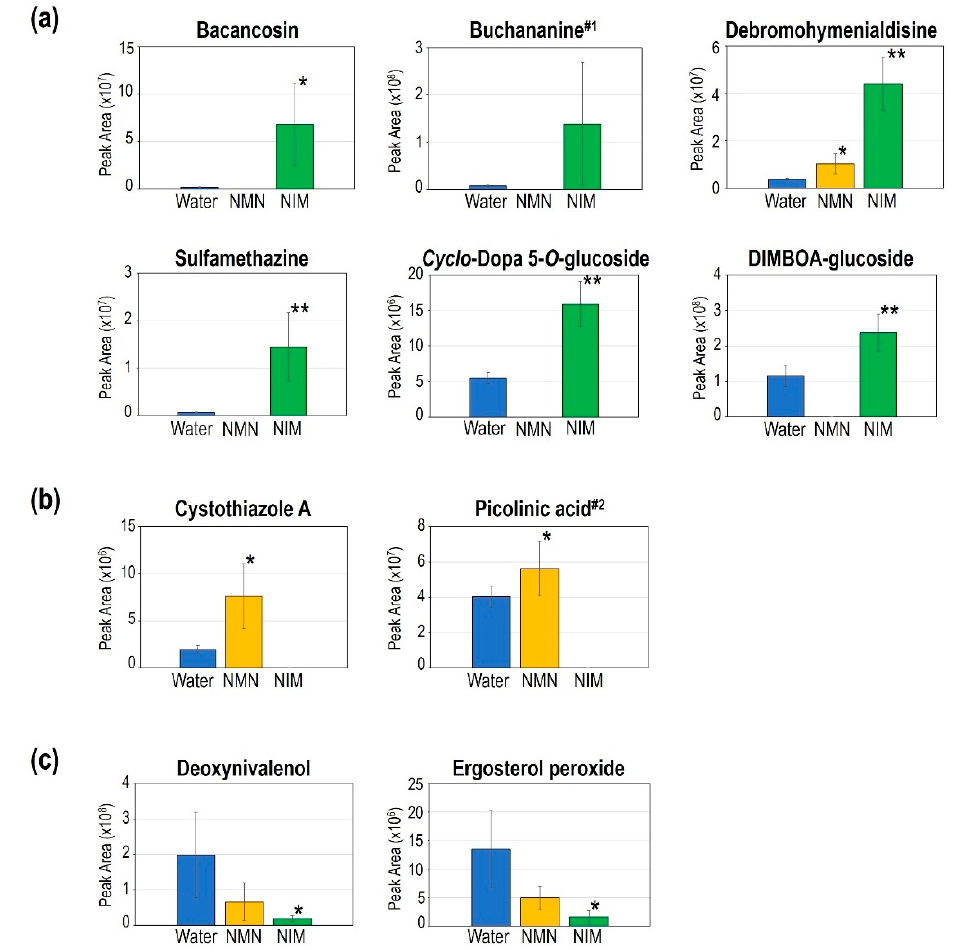
Figure 5. Representative differentially regulated metabolites by nicotinamide mononucleotide (NMN) and nicotinamide (NIM) pretreatment in inoculated spikes at 7 dpi. ( a ) Metabolites significantly accumulated by NIM pretreatment, ( b ) metabolites significantly accumulated by NMN pretreatment, and ( c ) metabolites significantly reduced by NIM pretreatment. The peak areas of the vertical axis show the abundance of each metabolite. (1) Buchananine was more than 1.5-fold more accumulated without statistical significance in NIM-pretreated spikes. (2) Picolinic acid was significantly accumulated in the NMN-pretreated spikes with a less than 1.5-fold change. Each bar represents one standard deviation ( n = 4–5). Student’s t -test: * p < 0.05, ** p < 0.01.